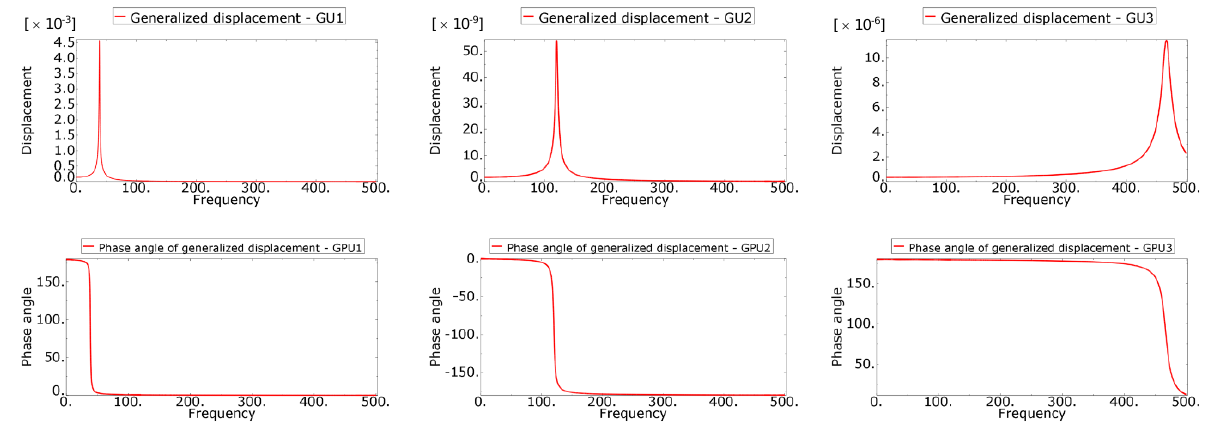
Figure 13. Linear dynamic responses.